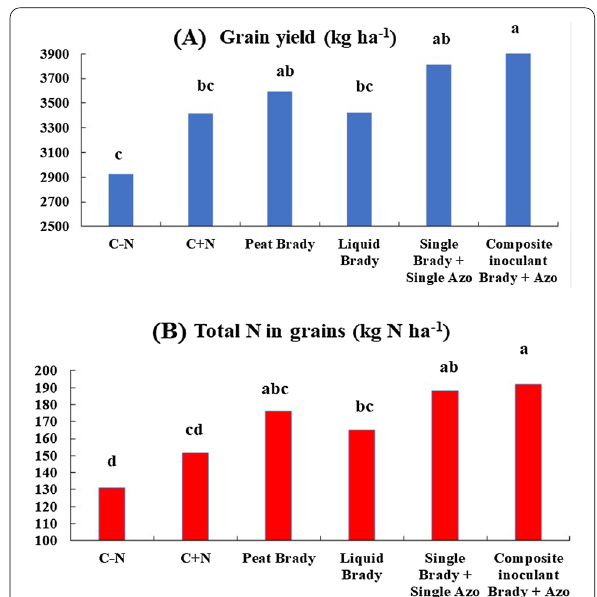
Fig. 2 A Grain yield and ( B ) total N accumulated in soybean grains resulting from single inoculation with peat and liquid inoculant of Bradyrhizobium , in co-inoculation with single Bradyrhizobium and single Azospirillum and with the co-inoculant carrying both Bradyrhizobium and Azospirillum . Data represent the means of five field experiments, each with six replicates and when followed by the same letter are not statistically diferente (Duncan, p <